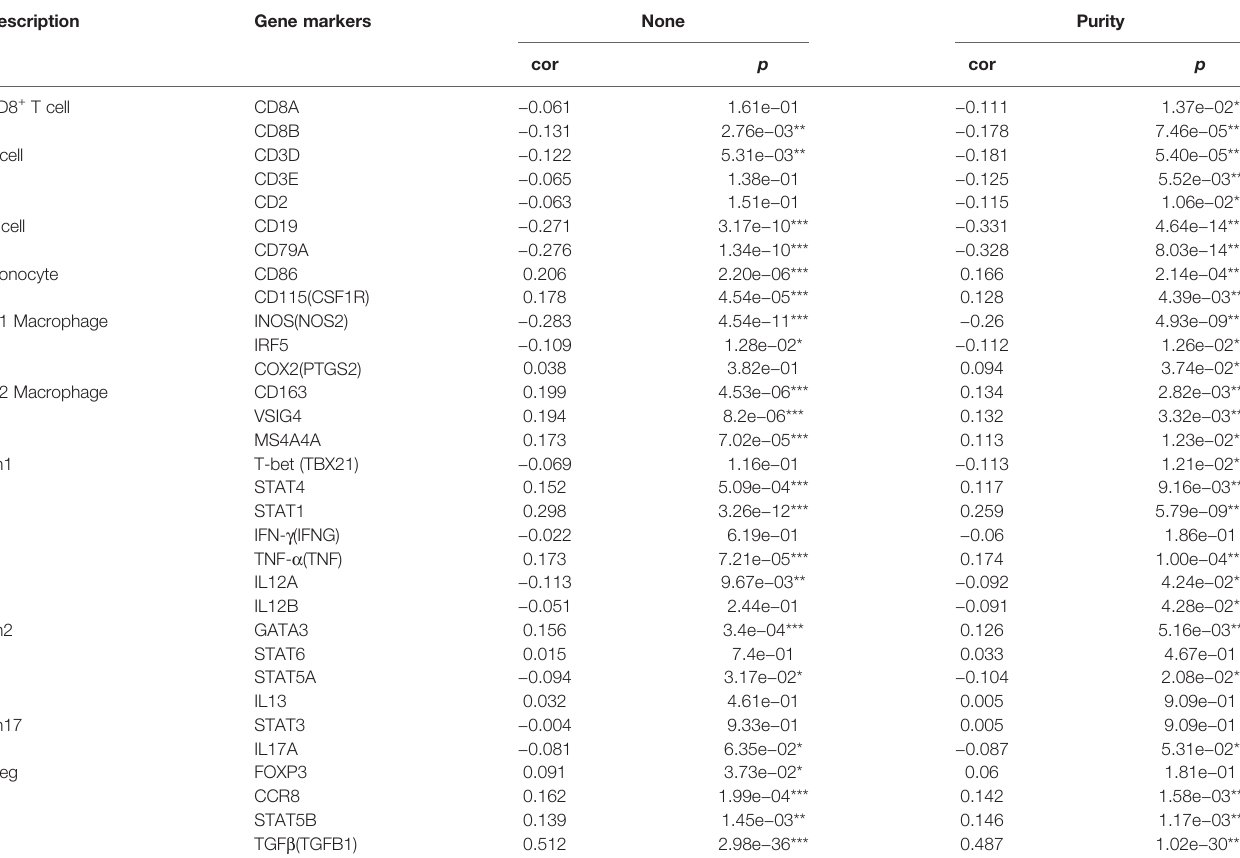
TABLE 3 | Correlation of DCBLD1 and immune cell markers analyzed by TIMER. Description Gene